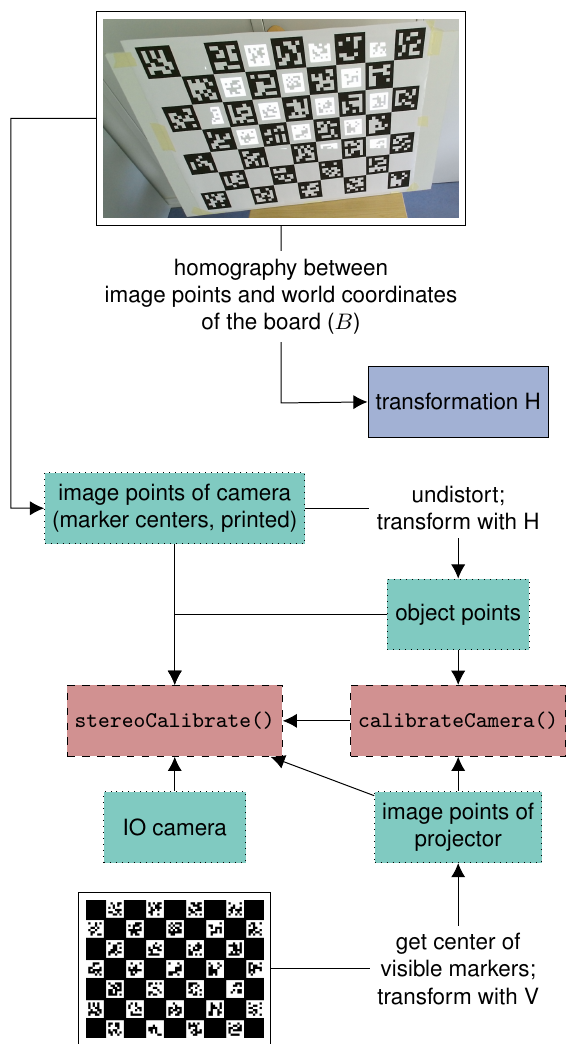
Figure 4. Flowchart with the steps that are required to calibrate the relative pose between the camera and the projector.